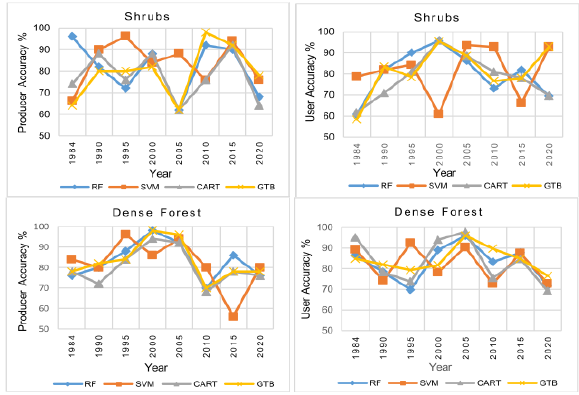
Figure 10 . PA and UA results for vegetation